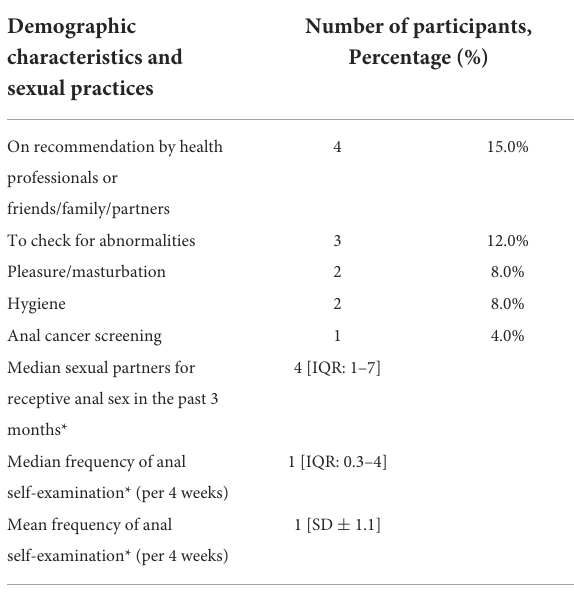
TABLE 1 Demographic characteristics and sexual practices among 30 participants at